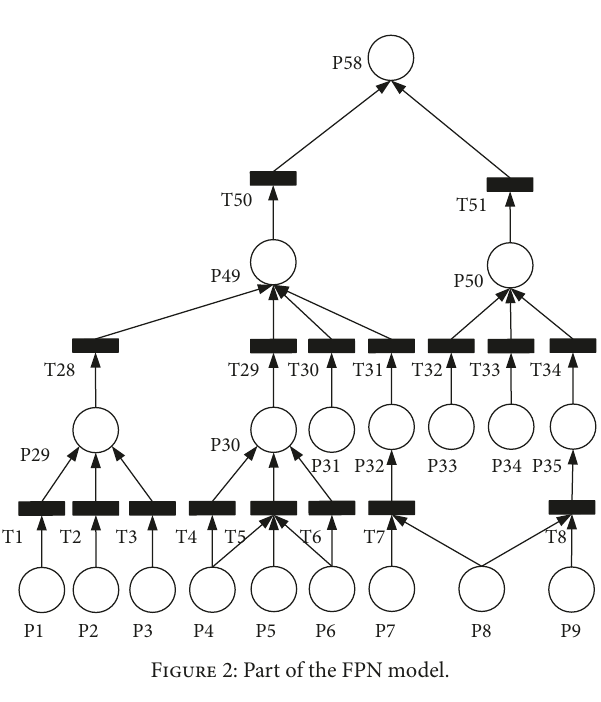
Figure 2: Part of the FPN model.